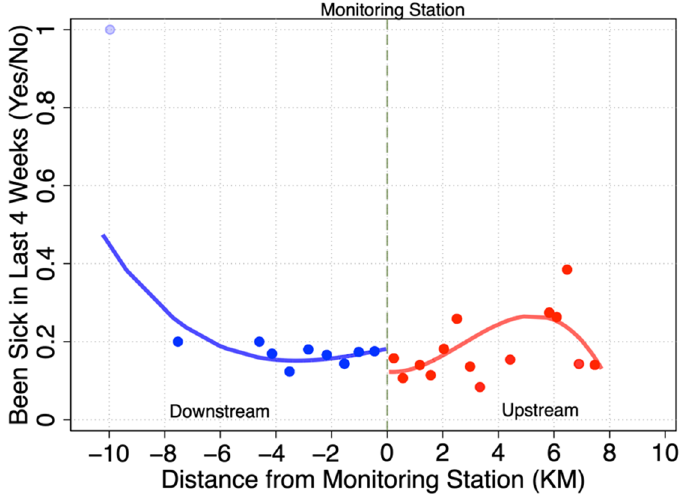
Figure 3. RDD plot of the effects of water quality monitoring on health.